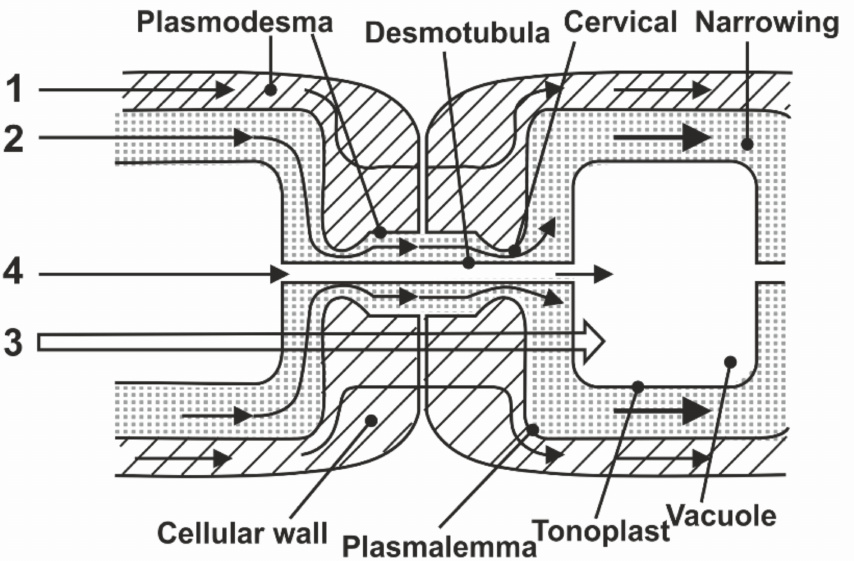
Figure 13. Model of transfer by a vacuolar symplast through desmotubule: (1) Apoplasmic way through the cells walls; (2) symplast way on cytoplasm plasmodesmata; (3) cell-to-cell way through tonoplast, cytoplasma, plasmalemma, and cell walls; (4) symplast vacuolar way through desmotubula plasmadesmata and